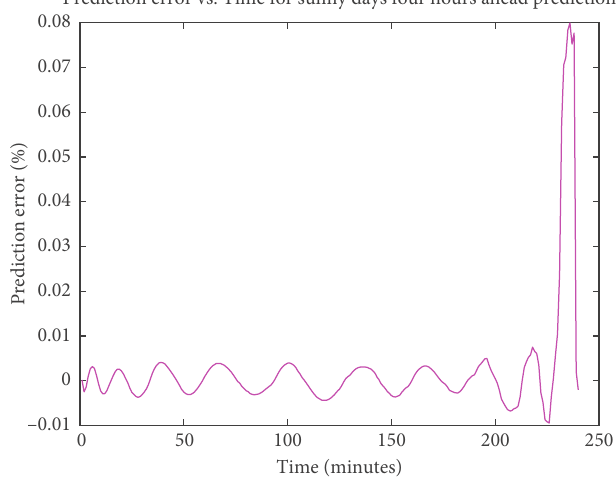
Figure 14: Prediction error vs. time for sunny day four-hour-ahead prediction.